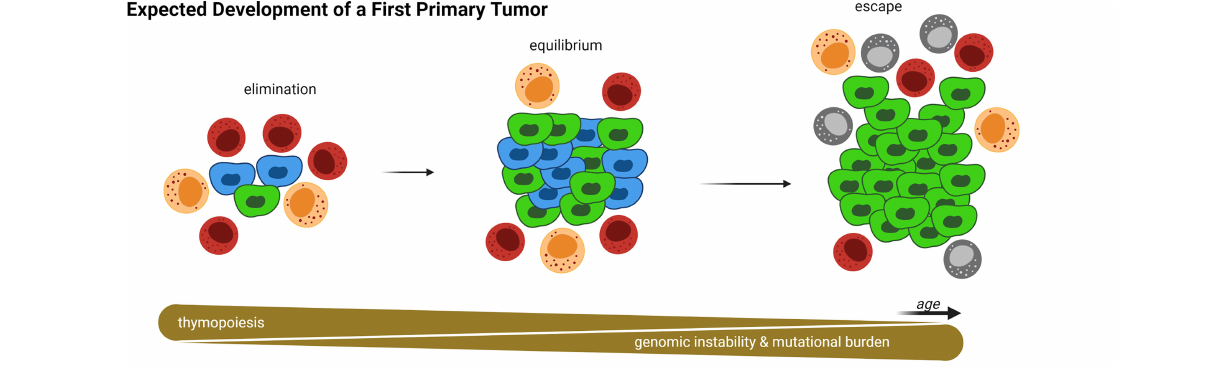
Integration site-4 (WNT4) (178), Bone Morphogenetic Protein-4 (BMP4) (174), and Interleukin-22 (IL22) (172). Most of these endogenous pathways orchestrate complex intrathymic circuitries,